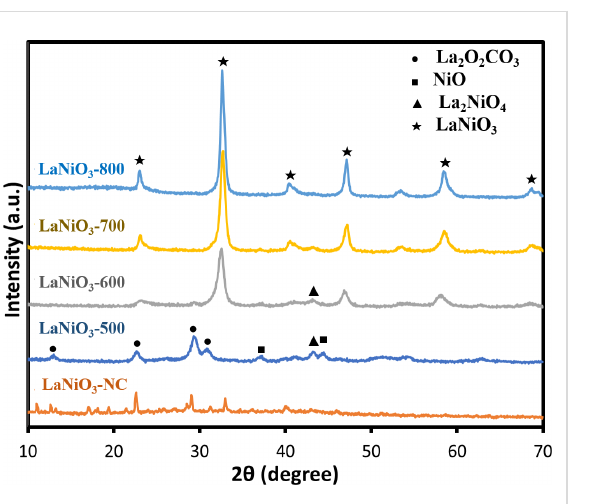
Figure 1: The characteristic XRD patterns of LaNiO 3 at different calci- nation temperatures. Similarly, LaFeO 3 samples with different calcination tempera- tures of uncalcined, 500, 600, 700, and 800 °C were noted as LaFeO 3 -NC, LaFeO 3 -500, LaFeO 3 -600, LaFeO 3 -700, and 2 θ peaks of 22.6°, 32.2°, 39.6, 46.3°, 57.4°, and 67.4° indicated